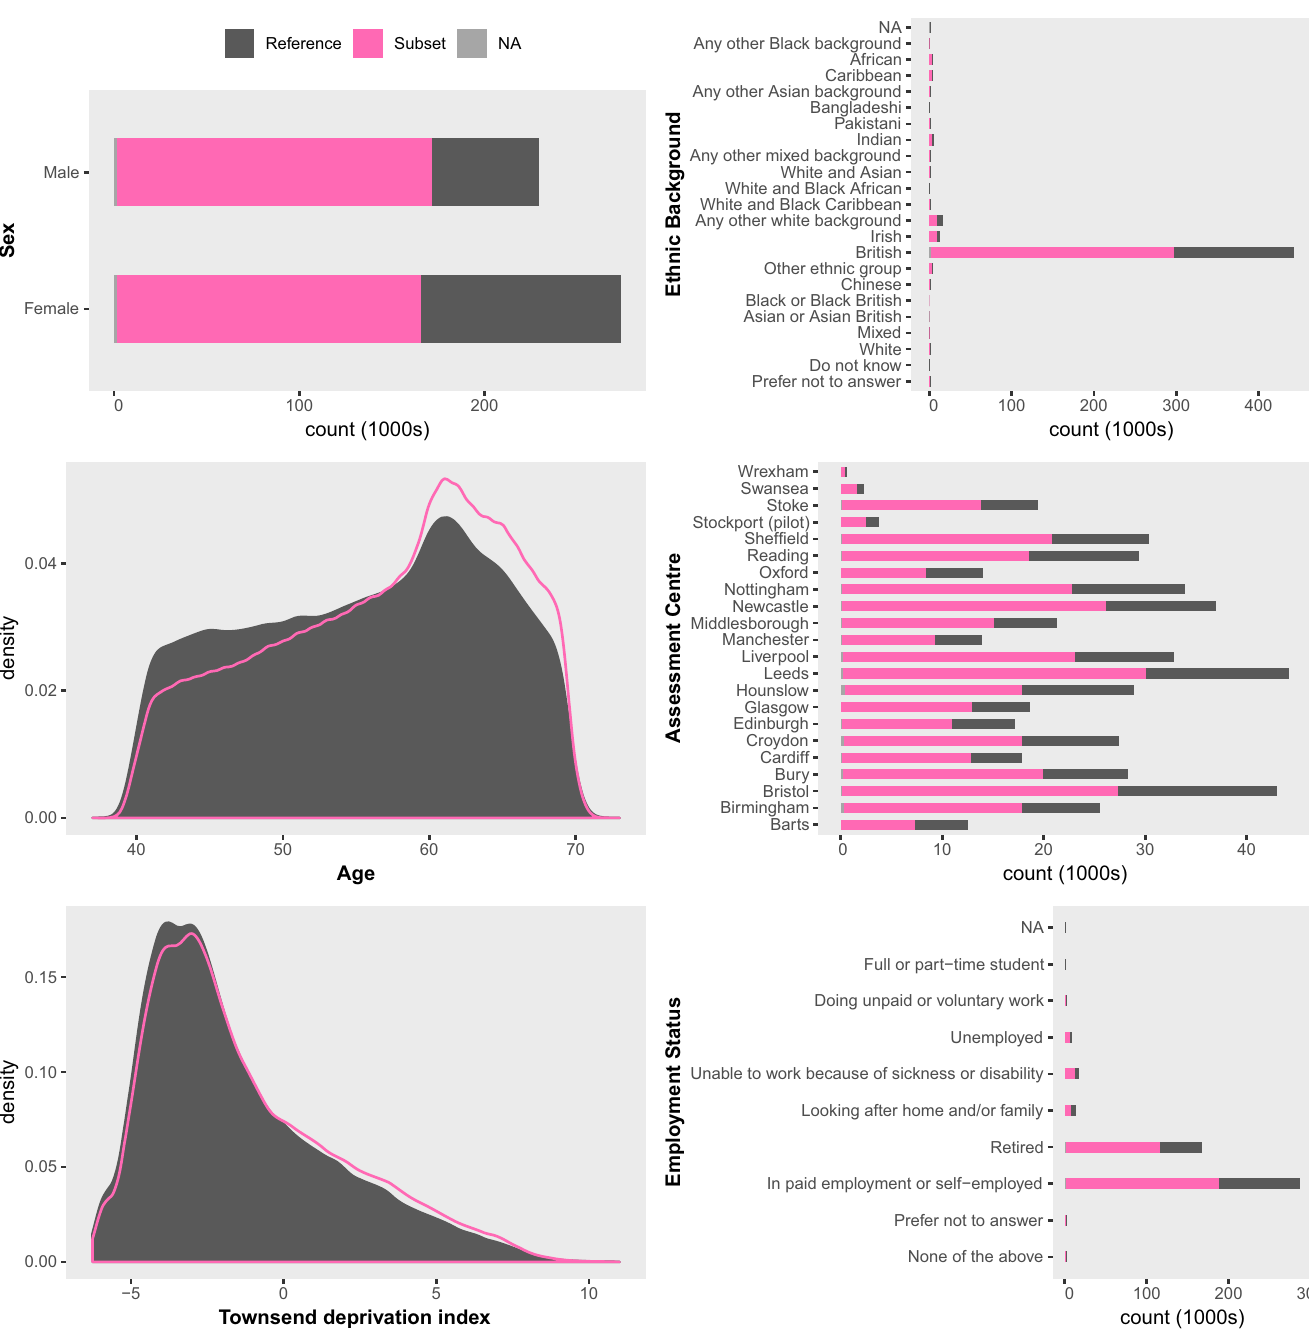
Fig 1. Primary demographic data for a UKB subset of interest. The subset is individuals with BMI > = 25; the reference is BMI < 25. Barplots are displayed as proportions, e.g., Ethnic Background in the top right panel shows about 1/3 of all participants who identified as "Chinese" were overweight compared to about 2/3 of all participants who identified as "British". ukb_context also allows the user to draw barplots as "stacked" or "side-by-side" bars representing counts, which would reveal there were many more "British" participants (442,698) than there were "Chinese"